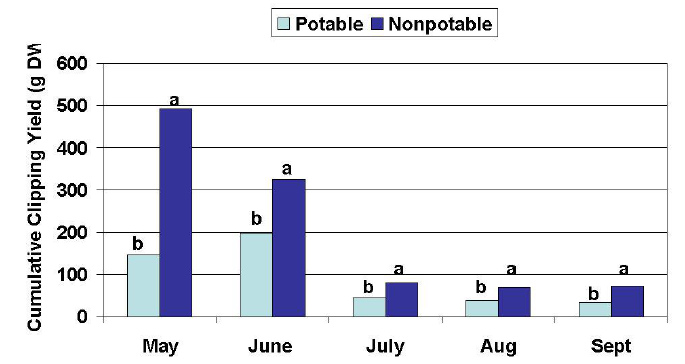
Figure 2. Effects of irrigation water source and wear on clipping yield of „L-93‟ creeping bentgrass in 2005. Wear was applied weekly in May, July, and September. Treatments by months with different letters are significantly different at 0.05 of